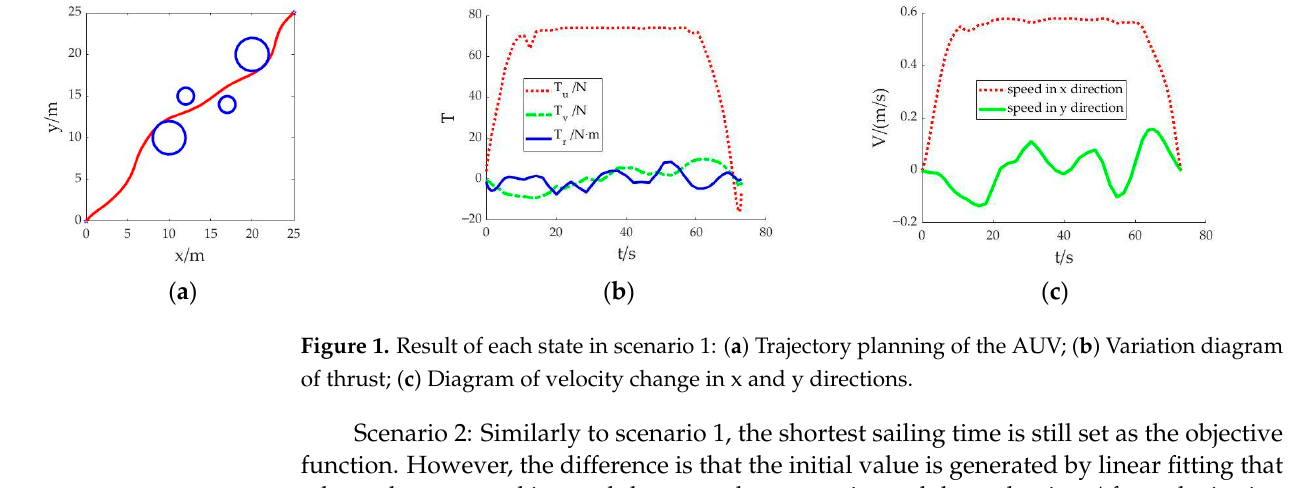
Figure 1. Result of each state in scenario 1: ( a ) Trajectory planning of the AUV; ( b ) Variation diagram of thrust; ( c ) Diagram of velocity change in x and y directions.